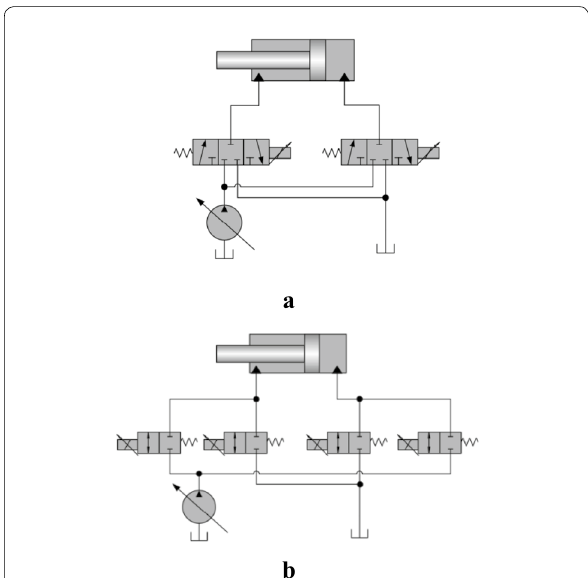
Figure 10 Schematic diagram of the independent metering